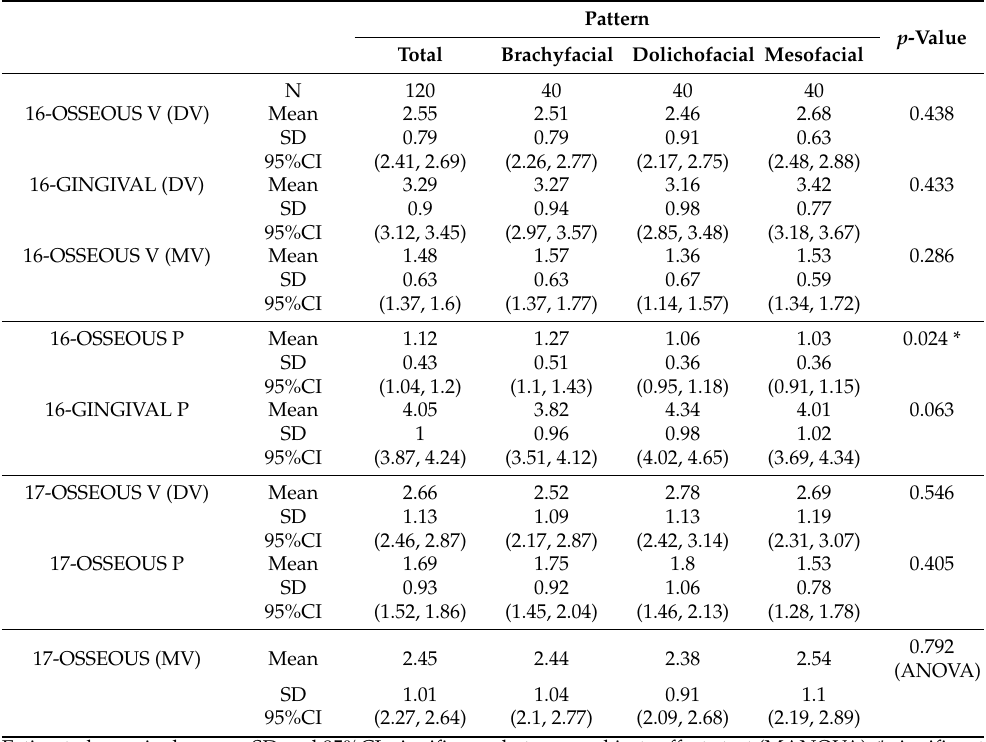
Table 2. Linear measurements corresponding to upper right molars in the different vertical facial patterns.